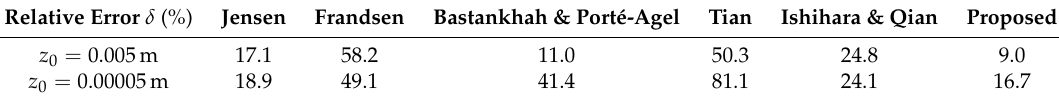
Table 2. Relative errors of the models in two cases with different roughness lengths. Relative Error δ (%) Jensen Frandsen